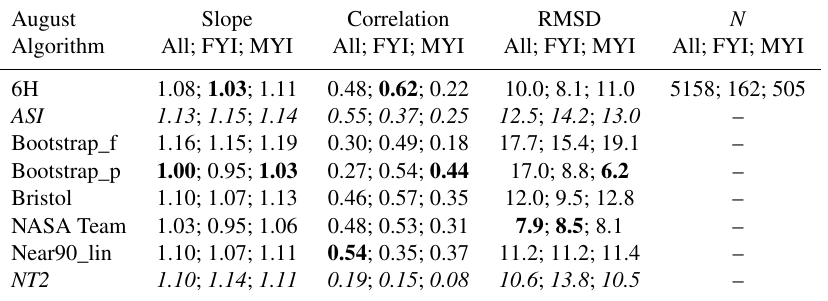
Table 7. Statistical parameters of the comparison AMSR-E sea-ice concentration vs. MODIS sea-ice concentration (see Fig. 4) for August 2009. Each column gives the value for all grid cells with MODIS sea-ice concentration > 20%, the multiyear (MYI) ice grid cells, and the first-year ice (FYI) grid cells (see Sect. 2.4). Slopes closest to 1, highest correlations, and lowest RMSD values are noted in bold font. Values obtained for the ASI and NT2 algorithm are shown for completeness but are in italic font. August